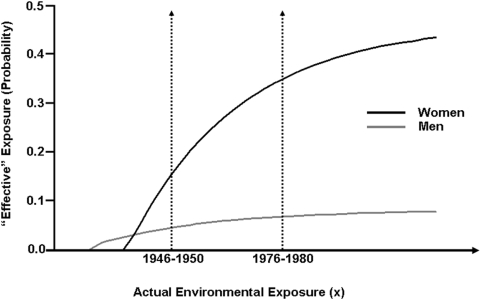
Derived response curves for men and women of an “effective” exposure to the environmental factors (PE*) with increasing levels of actual exposure (x), as described in the text and in the Appendix.These curves are based upon the “current” proband-wise monozygotic-twin concordance-rates for men and women in Canada [10] and upon the change in the sex-ratio observed in Canada between the two time-periods [65]. However, in deriving this set of curves, two further assumptions have been made. First it has been assumed that the currently observed values for Zw2 and Zm2 are accurate [10]. Second, it is assumed that C (defined in Table 2) is equal to one half (i.e., that the prevalence of MS has doubled between the two time intervals). Of course, the actual level of environmental exposure (whatever this represents) is unknown. Nevertheless, the environmental exposure has been scaled such that the difference in the actual exposure level between these two time-periods (whatever this is), multiplied by the unknown hazard rate, is assigned the arbitrary value of one exposure unit (see Table 2). In these curves, the probability of a “sufficient” exposure to the entire set of environmental events (PE) is assumed to have changed (in some manner) as the actual level of exposure (x) of the population has increased between the two time intervals of study. This change in (PE), however, could be due to a change in only one, in some, or in all of the relevant environmental factors. NB: Although the two time-periods of (1941–1945) and (1976–1980), which were used for parameter estimation, are shown along the x-axis, this axis represents an increasing (but unknown) environmental exposure. It is not a time-axis.